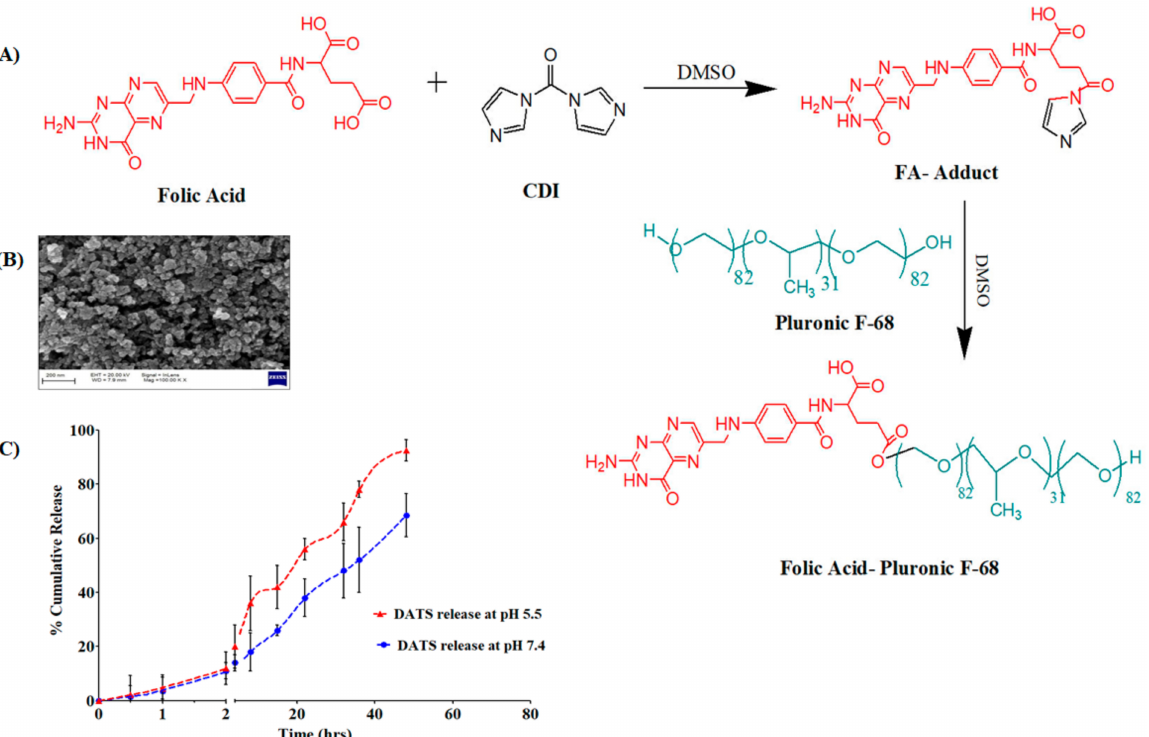
Figure 3. ( A ) Synthesis pathway of the FA-Pluronic F-68 surfactant for the formulation of DATS-SLNs. ( B ) SEM image of FA-DATS-SLNs for the morphology study. ( C ) In vitro DATS release in two different pH